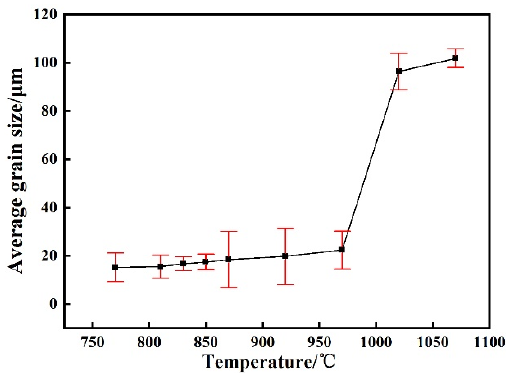
Figure 7. Austenite grain growth curve of the rolled specimens.